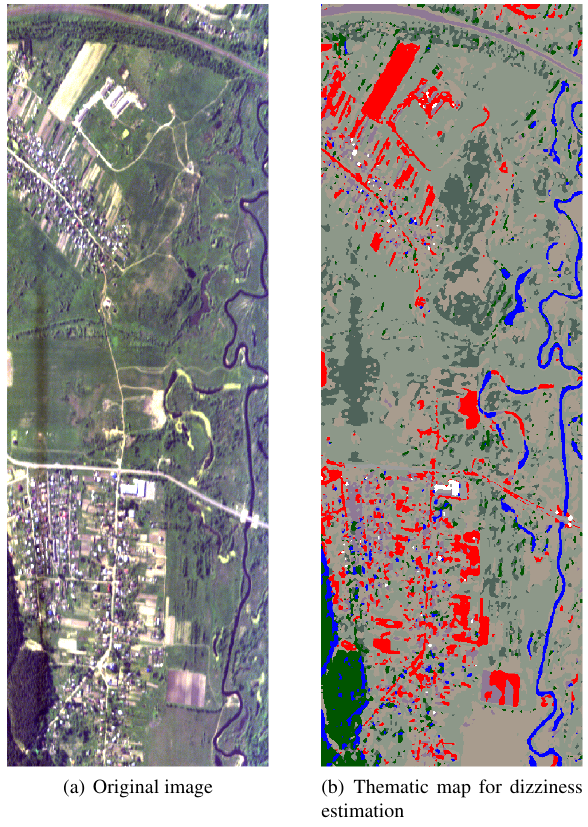
Figure 3: Image selected for processing matrix is an a priori generated weighting matrix, while version with DN modifies the very concept of Mahalanobis distance and makes it not scale-invariant (brighter areas are considered more